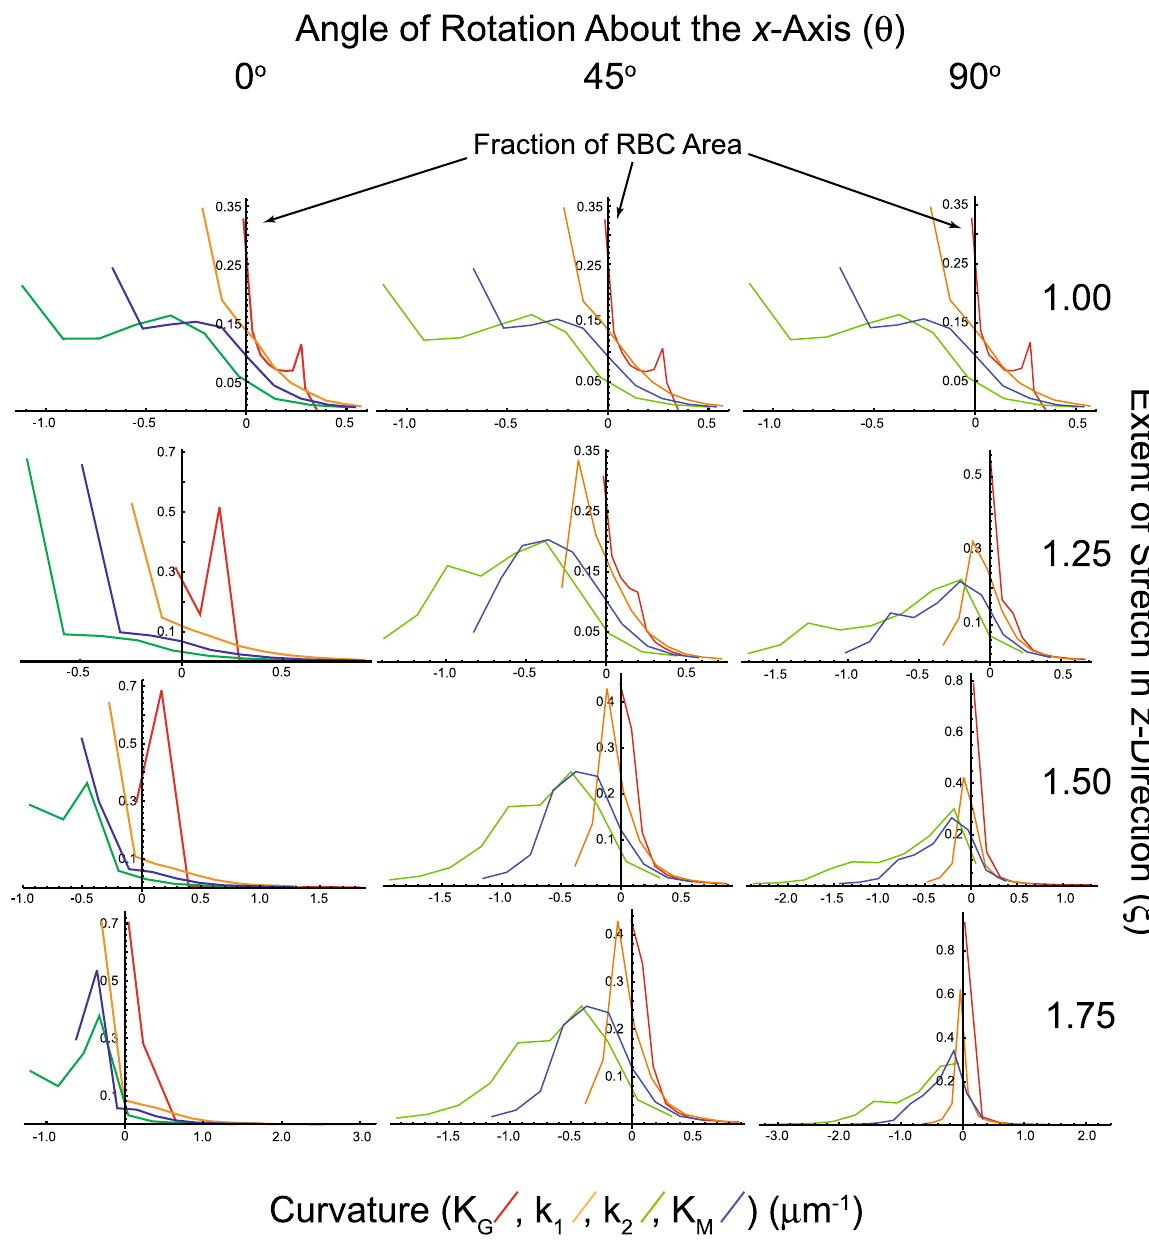
Figure 7. Curvature graphs of an RBC rotated at 0°, 45° and 90° around the x -axis and stretched in the z -direction by the extents (ξ) indicated on the right. The colours of the polygonal plots indicate: Gaussian Curvature K G (μm −2 ), red; Principal Curvature (maximum), k 1 , orange; Principal Curvature (minimum), k 2 , green; and Mean Curvature K M , blue. Each discontinuity of the polygons denotes the mean value in curvature of the bin in the given curvature